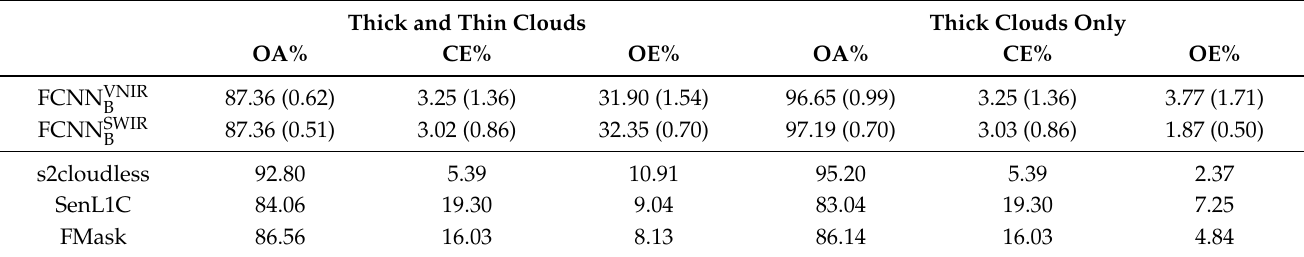
Table 7. Results of FCNN B models, s2cloudless, and FMask evaluated on the pixel-wise S2-Hollstein dataset. Thick and Thin Clouds Thick Clouds Only OA% CE%